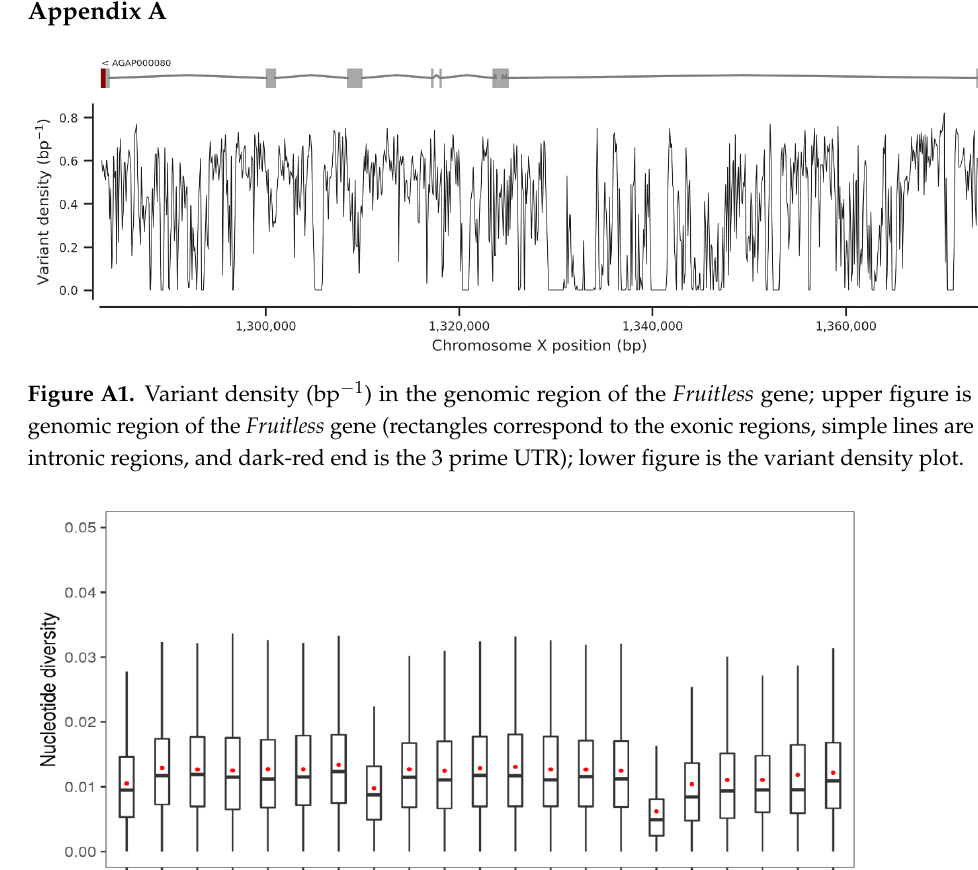
Figure A3. Median of Tajima ’ s D in a window of 500 bp across the genomic region of the Fruitless gene; red points indicate the mean of the Tajima ’ s D. Horizontal line indicates the null value of the Tajima’s D test. AGO: Angola; BFA : Burkina Faso; CAF : Central African Republic; CIV : Côte d’Ivoire; CMR : Cameroon; COD : Democratic Republic of Congo; GAB : Gabon; GHA : Ghana; GIN : Guinea; GMB : Gambia; MLI : Mali; MOZ : Mozambique; MWI : Malawi; TZA : Tanzania; UGA : Uganda.